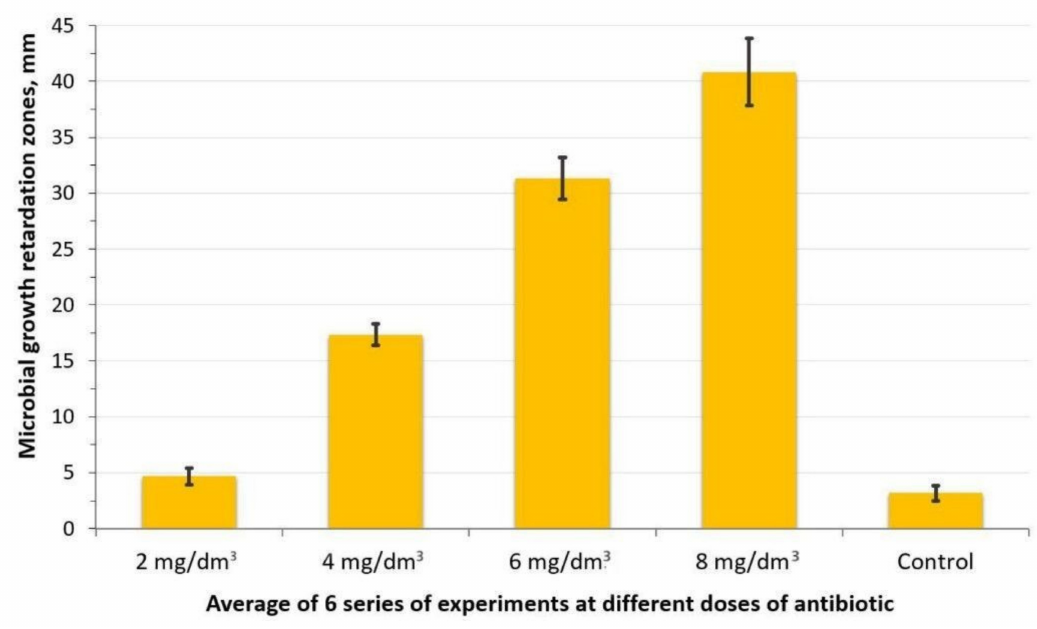
Figure 7. Interpretation of the results of determining the sensitivity of the storage culture of activated sewage